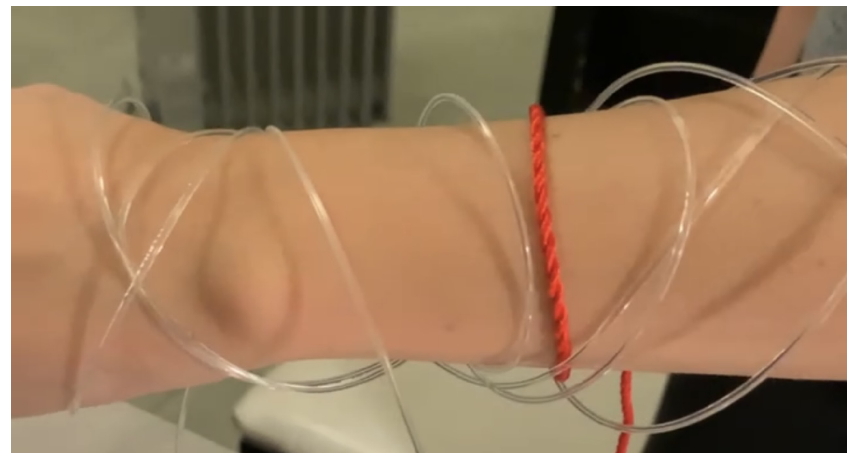
Figure 15. Early prototype, normal condition.